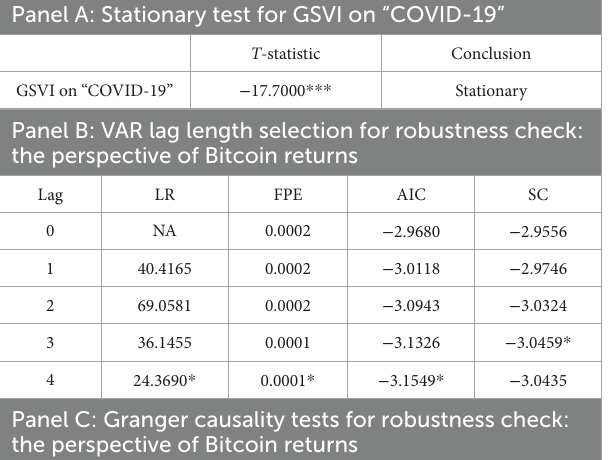
TABLE 7 Bitcoin volatility robustness check: updating the search